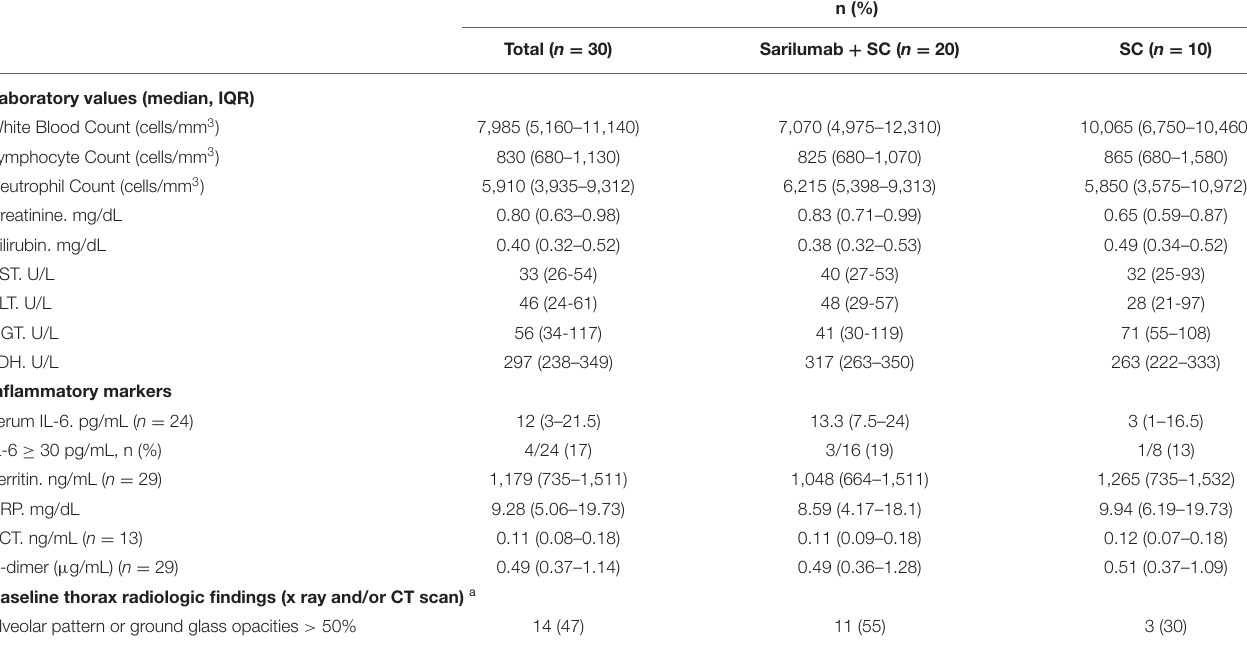
TABLE 2 | Baseline laboratory and radiologic findings of the study